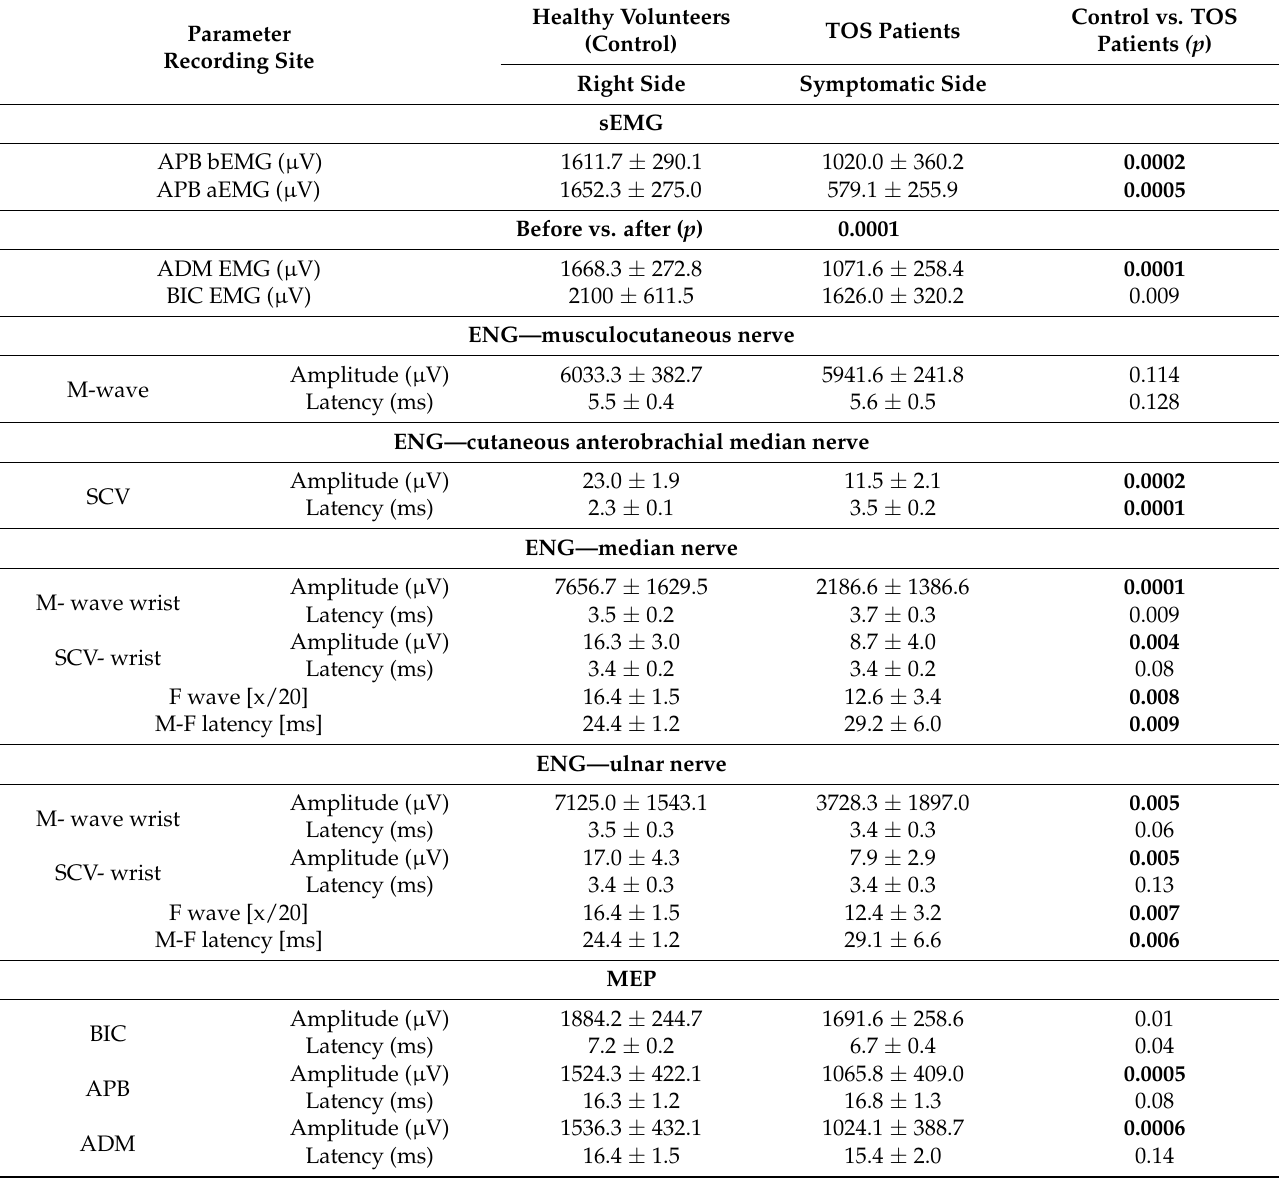
Table 3. Comparison of the results of neurophysiological tests in healthy subjects (N = 60) and TOS patients (N = 60). The mean values with standard deviations are presented. The most significant p -values < 0.05 are marked in